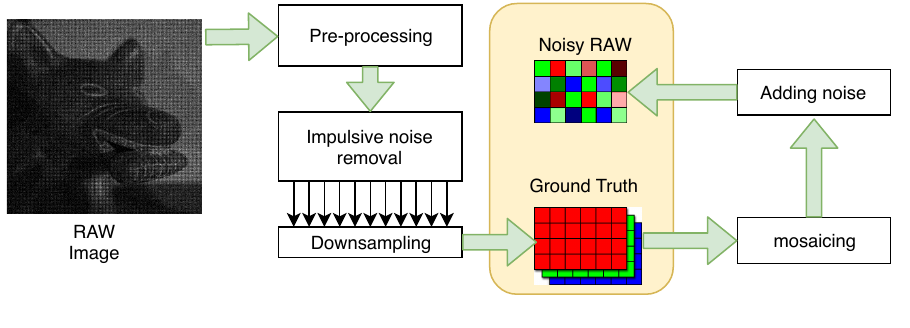
Figure 5. Idea of test image generation.